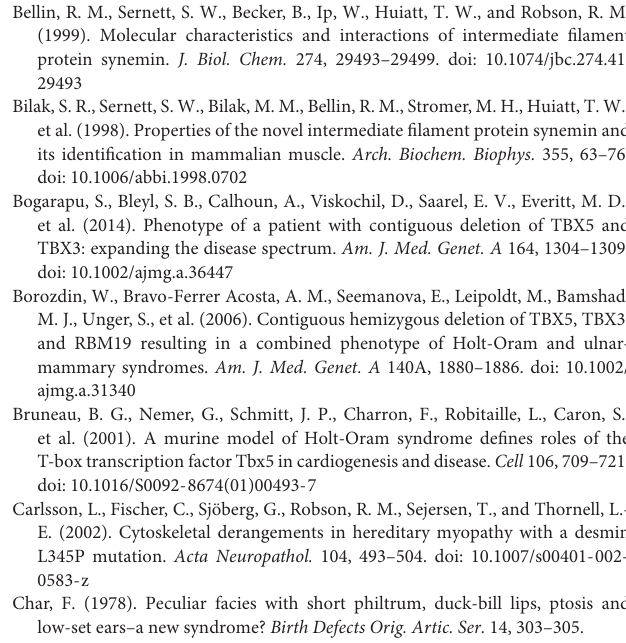
FIGURE S1 | Pedigree chart of the reported family. Gray color indicates mother’s phenotype partially overlapping with the proband’s clinical picture. Question mark indicates unavailable data on the phenotype. TABLE S1 | Whole-exome sequencing data: a list of genetic variants filtered according to their exonic function and population allele frequencies. As a result, 402 rare protein-changing variants (missense, frameshifts, nonsense and predicted splice sites) with AF < 0.001 (ExAc and gnomAD databases) were